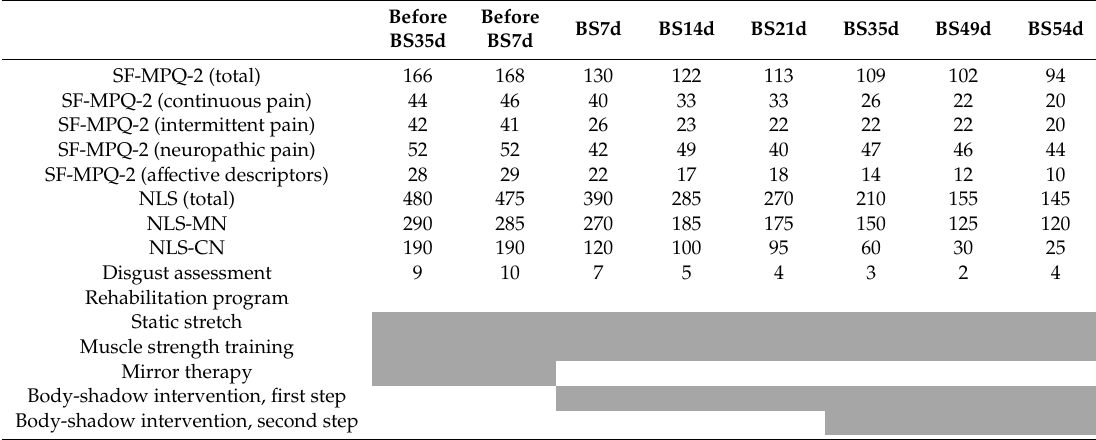
Table 1. Neglect-like symptoms (NLS) and disgust for the a ff ected lower